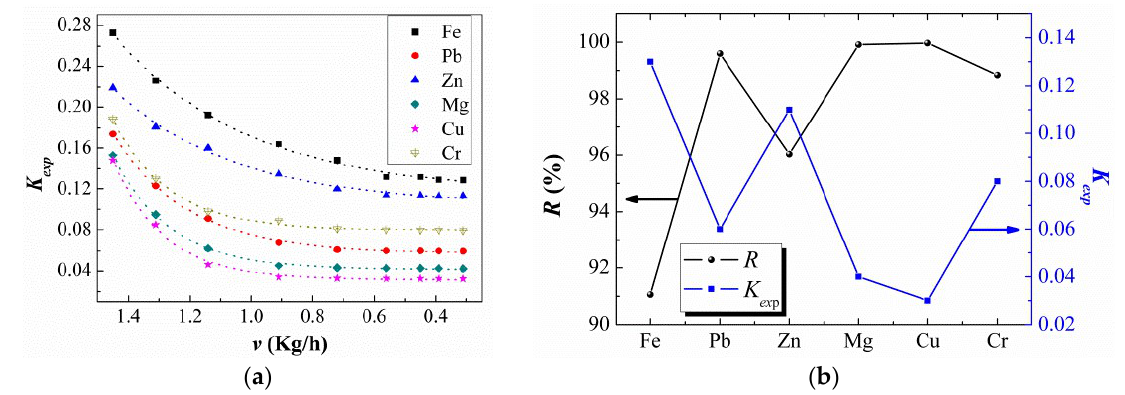
Figure 6. ( a ) Effect of solidification rate v on the experimental segregation coefficient K exp . ( b ) Relationship between the removal ratio for the impurities R % and the segregation coefficient K exp .